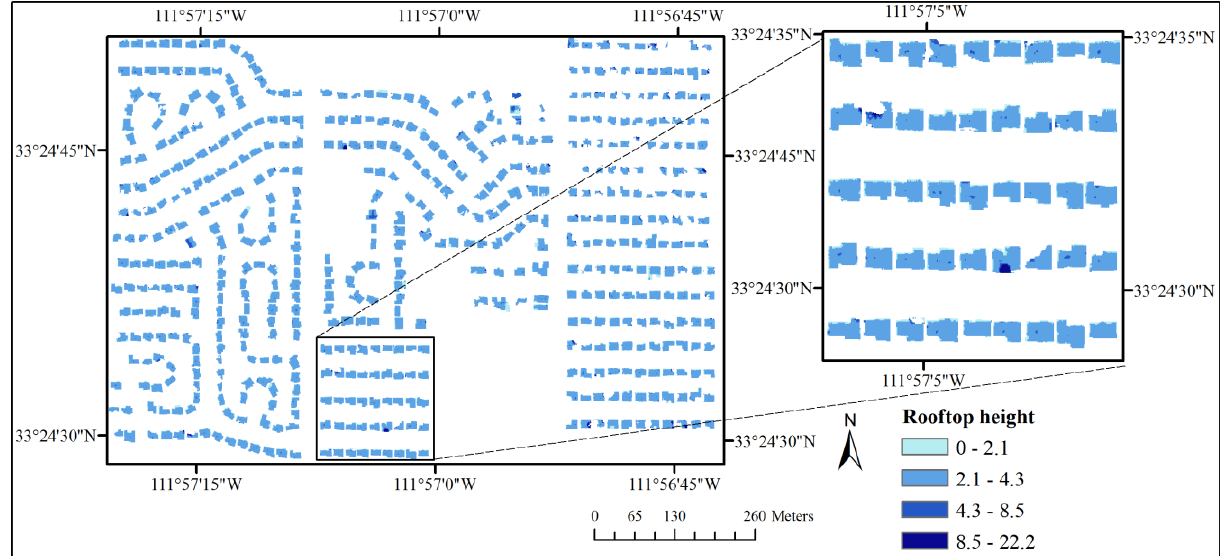
Figure 12. Rooftop